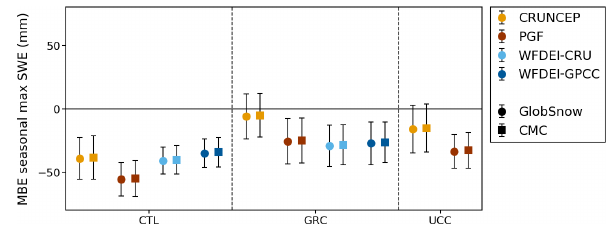
Figure 4. Mean bias error (MBE) of seasonal maximum SWE (mm), averaged over all basins (Eq. 2) and calculated over the com- mon overlap period, 2002–2010. The error bars show the basin- averaged standard deviation, σ S (Eq. 4).